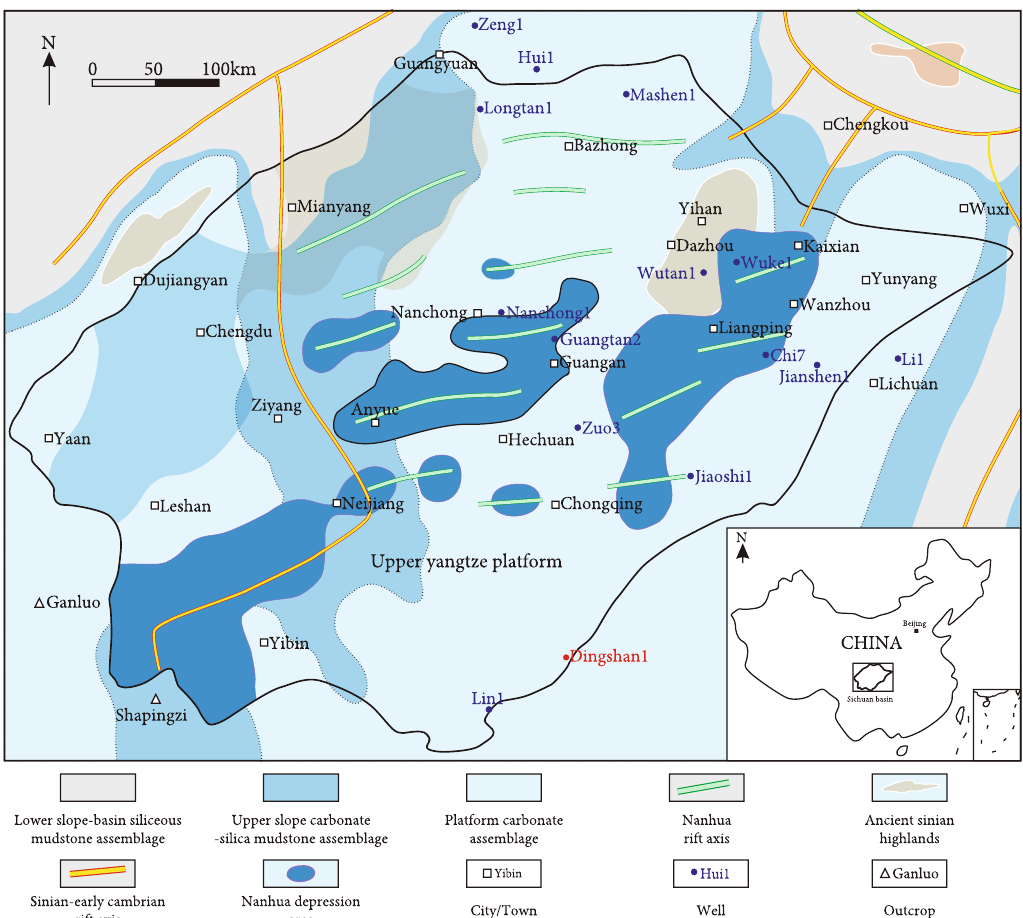
Figure 1: The Sinian-Early Cambrian uplift depression pattern of the Yangtze Craton